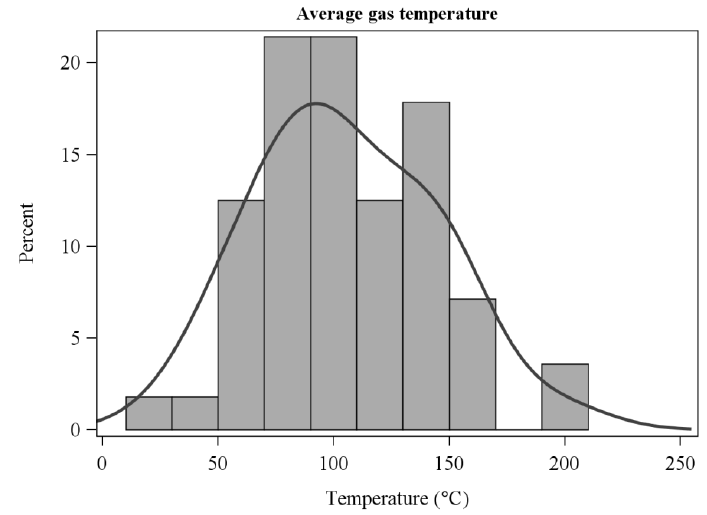
Figure 3. Frequency distribution of average gas temperatures over residence times measured with fine thermocouples.